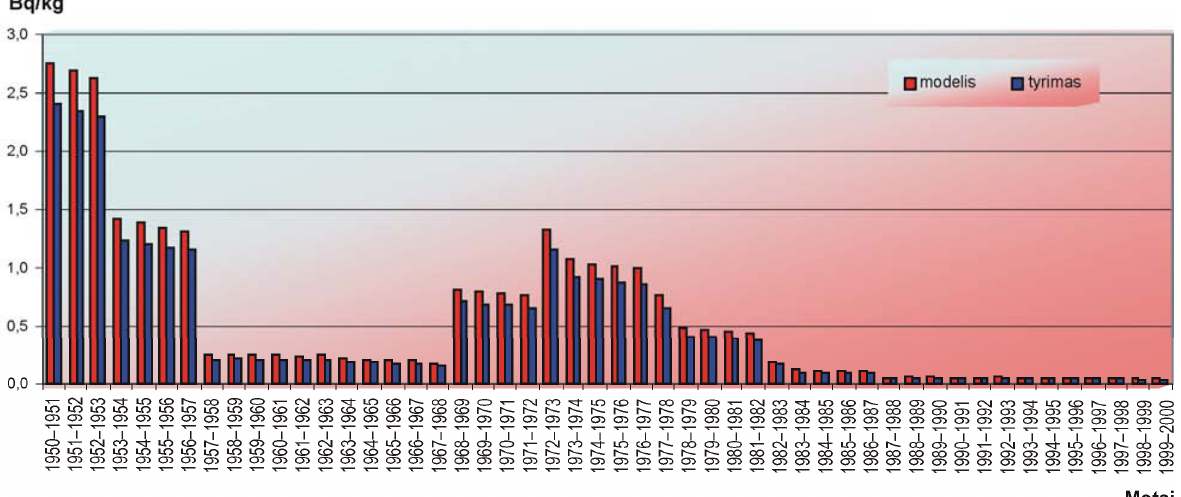
90 Sr activity in